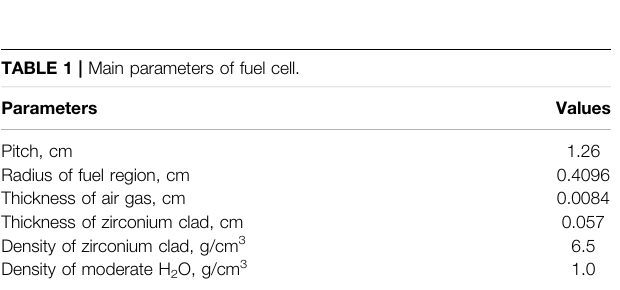
TABLE 1 | Main parameters of fuel